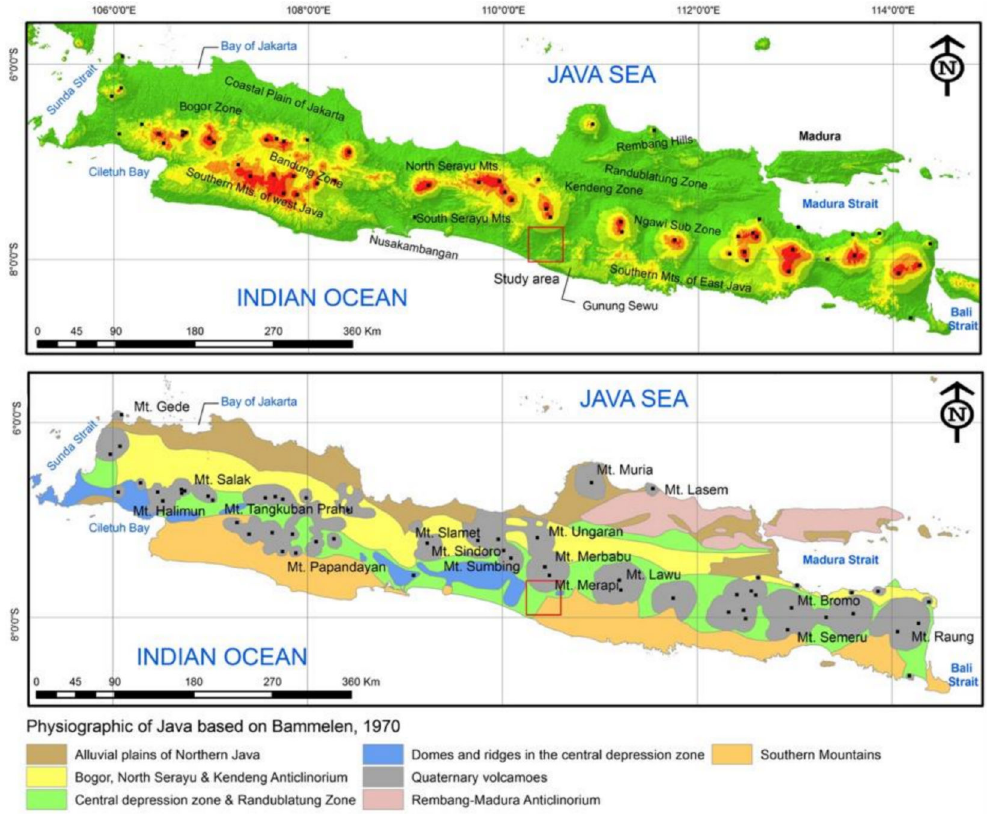
Figure 2. ( Top ) The elevation of Java, Source: SRTM USGS (https://earthexplorer.usgs.gov/); ( Bottom ) Physiographic of Java Islands (modified from [3]).